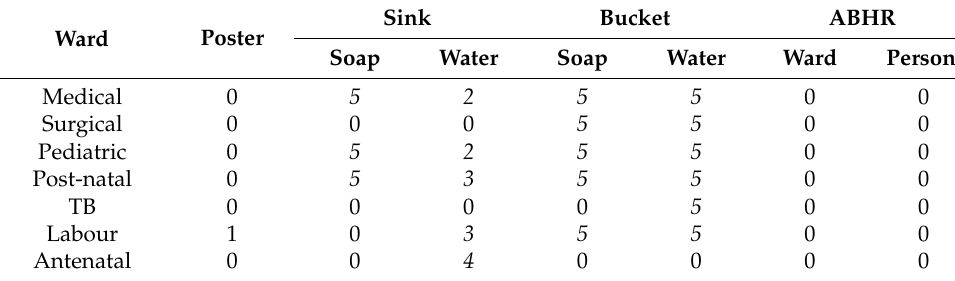
Table 6. Availability of hand hygiene